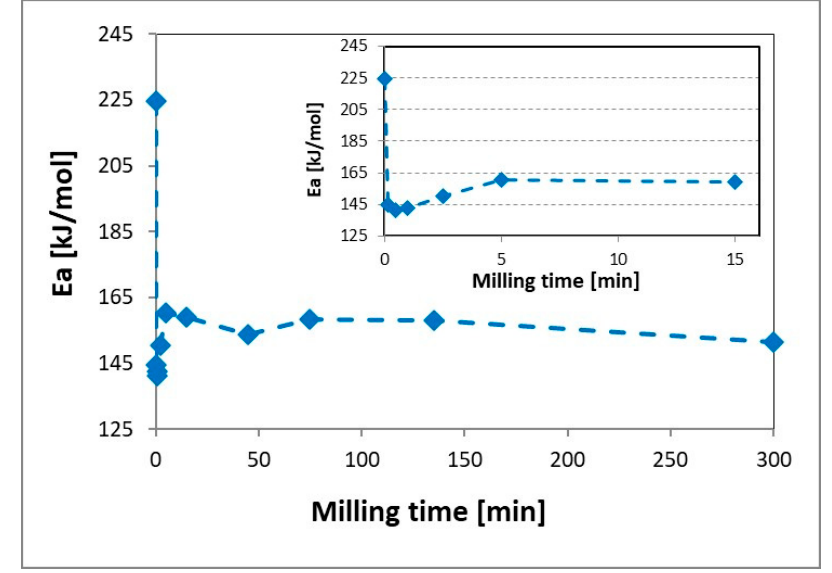
Figure 4. The changes in the activation energy E a for MgH 2 in as-received and milled forms.